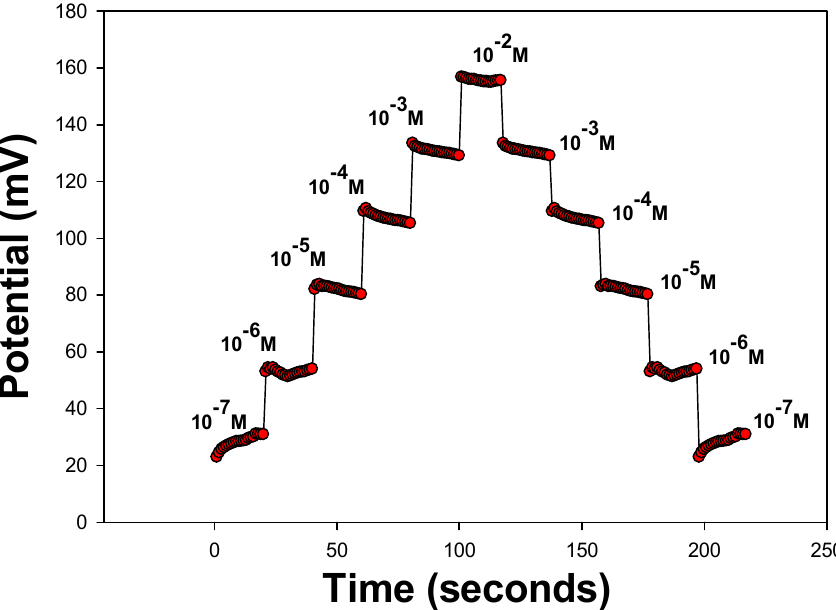
Figure 8. Dynamic response of sensor 4 over a wide concertation range of 2,4-D from 10 − 7 to 10 − 2 M at 25 °C prepared in Tris buffer (pH = 7.0).